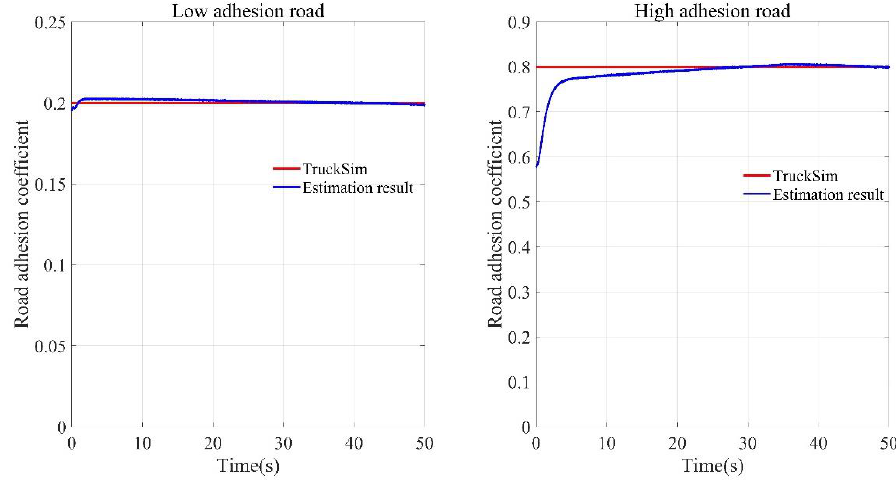
Figure 21. Estimation results of different road adhesion coefficient.